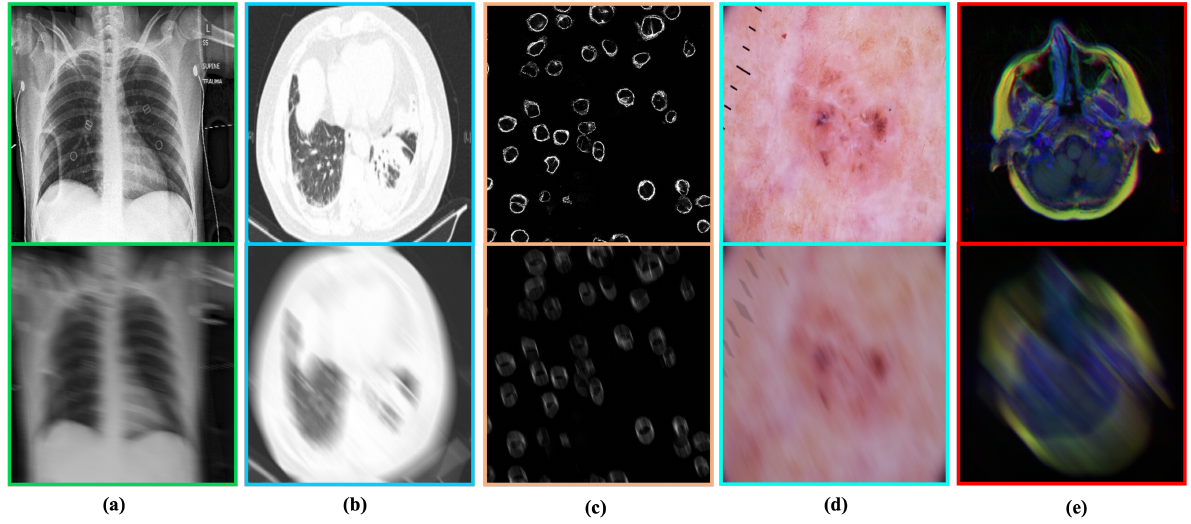
Figure 4. Blur–sharp image pairs generated by the proposed method. In each pair. Top: Ground-truth image. Bottom: Simulated blurry image. ( a ) Chest X-ray [29]. ( b ) COVID-19 CT scan [30]. ( c ) Human Protein atlas [28]. ( d ) HRM skin Lesion [31]. ( e ) MRI images